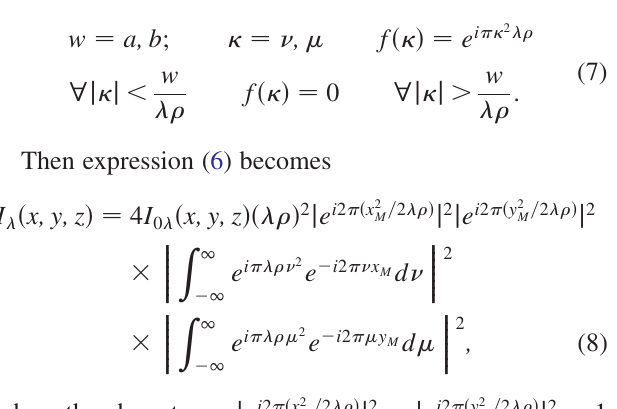
FIG. 6. (Color) Normalized Fresnel diffraction through a slit (maximum is equal to 1), varying the distance pinhole screen, z , and for source at infinity. The horizontal axis is expressed in units of the half-aperture a , and the vertical axis shows the . The dashed lines represent the first variation of z as Z ¼ z(cid:3) a 2 and second zeros of the far-field solution. The black line is the FWHM of the near field solution, and the dash-dotted line its asymptotic behavior. The dotted lines represents the aperture.